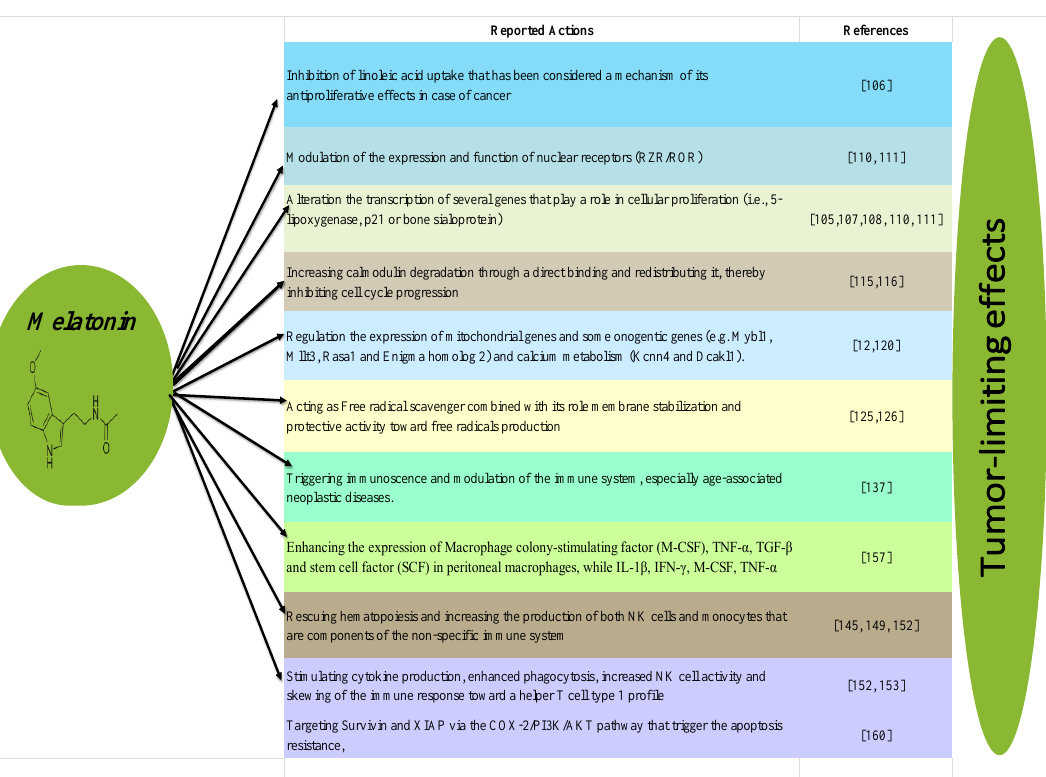
Figure 2. Tumor-limiting effects of melatonin and their suggested mechanisms.